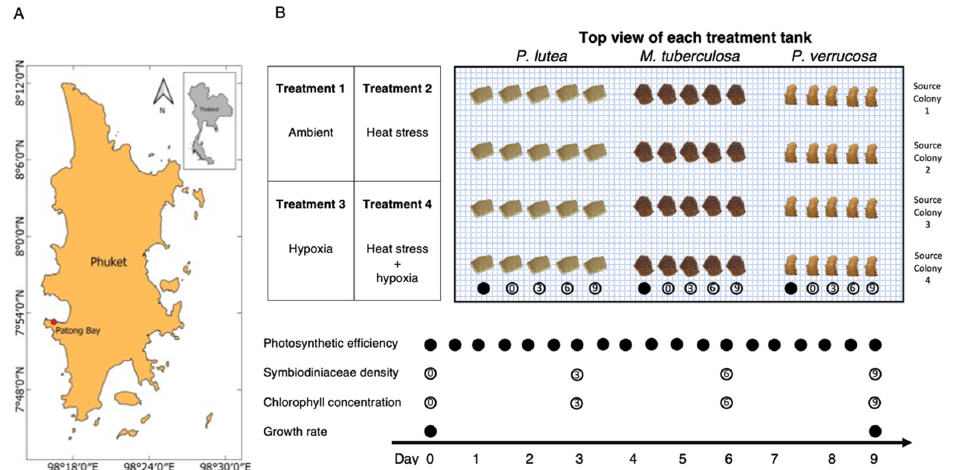
Figure 1. ( A ) Sampling site at Patong Bay, Phuket, Thailand. ( B ) Design of experiments and placement of coral nubbins (20 nubbins/species/tank) in the four treatments. The nubbins in the first row (black dots) were used for photosynthetic and growth rate measurements, while the next rows were used for destructive sampling of Symbiodiniaceae and chlorophyll analysis on days 0, 3, 6, and 9.